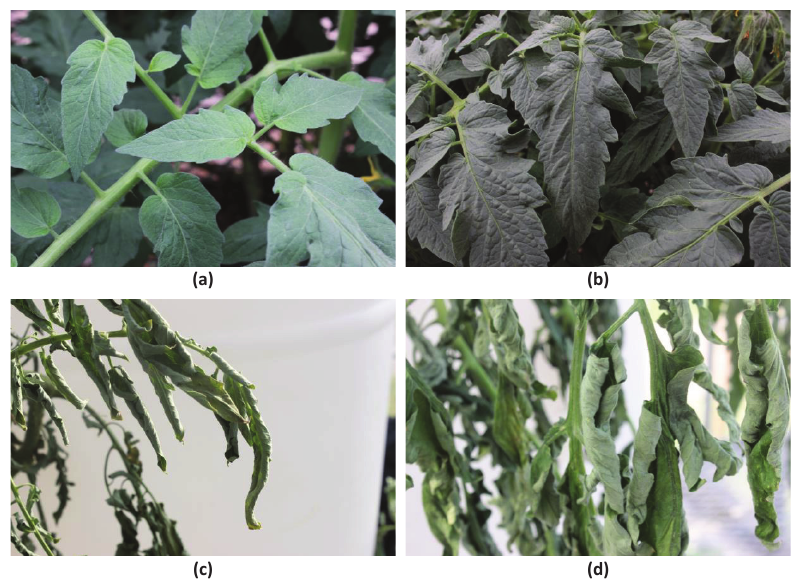
Figure 4. Examples of the healthy plants in ( a , b ) and the diseased plants in ( c , d